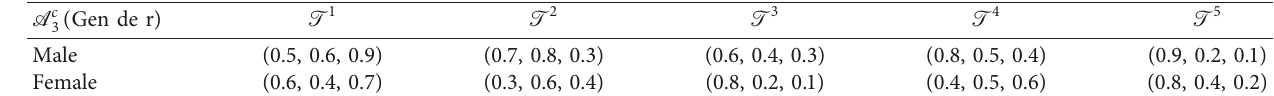
against gender. i